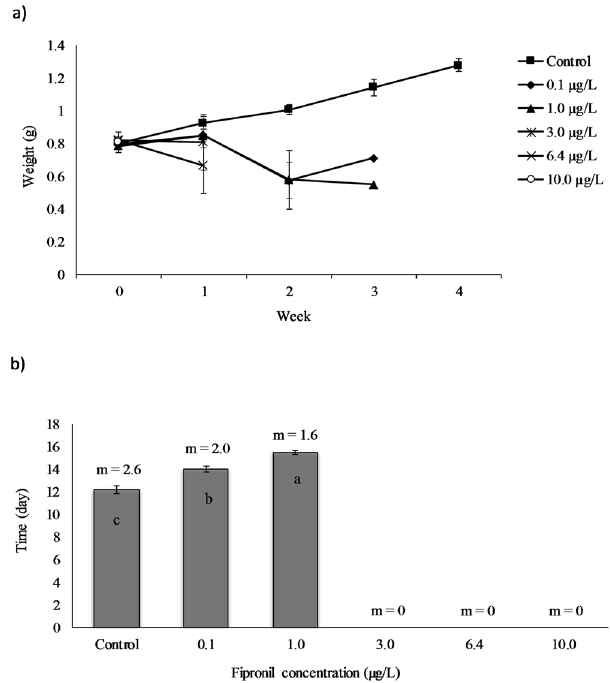
Figure 3. ( a ) Average weight (g wet weight per individual) of juvenile shrimp as a function of the duration of the exposure to fipronil. The horizontal axis represents the experiment period per week (week 0–week 4) while the vertical axis represents the average wet weight (g) per individual shrimp in each treatment. Error bars indicate the standard errors (n = 18). One-way Analysis of Variance (P < 0.05) showed that, after one week of fipronil exposure all treatments were significantly different from the control. ( b ) Inter-moult intervals of juvenile shrimp exposed to different concentrations of fipronil for 29 days. The horizontal axis represents the six fipronil concentrations ( µ g/L) including the control used during the experiment while the vertical axis represents time (per day) of the inter-moult intervals of juvenile shrimp. Error bars indicate the standard errors (n = 18). m is the average number of moults of individual shrimp in each treatment. Non- parametric Kruskal- Wallis test followed by the pairwise Wilcoxon rank sum test (P < 0.0001) showed that means in columns not sharing the same letter were significantly